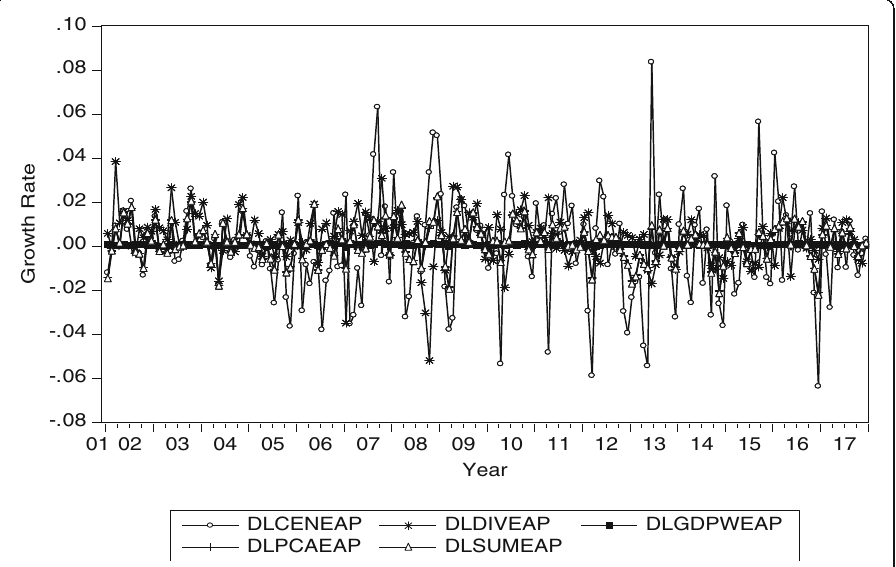
Fig. 1 Monthly Growth Rates of Monetary Aggregates of East Asia and the Pacific. DLCENEAP, DLDIVEAP, DLGDPWEAP, DLPCAEAP and DLSUMEAP are log differences of CE, Divisia index, GDP-weighted, PCA-based, and Simple-Sum measures for East Asia and the Pacific respectively. The numbers 01 through 17 on the horizontal axis represent the years 2001 through 2017